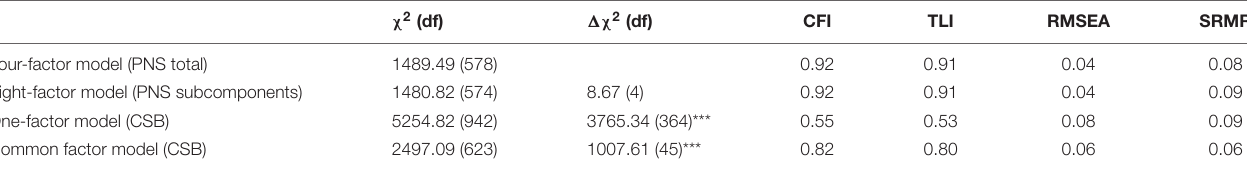
TABLE 1 | Models and fit indices.